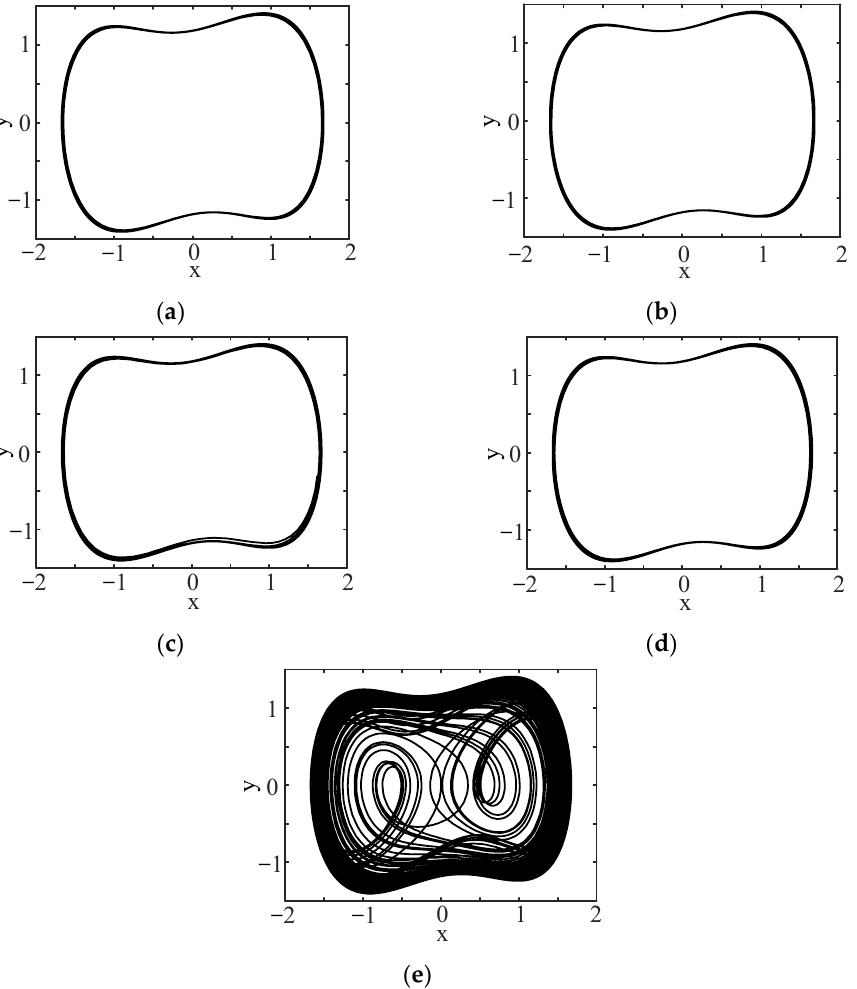
Figure 9. Phase trajectories of the Duffing Oscillator at 22.3~25.3 Hz: ( a ) 22.7 Hz; ( b ) 22.9 Hz; ( c ) 23.6 Hz; ( d ) 24.6 Hz; ( e ) Others. Table 3. The frequency of the periodic signal detected in six frequency